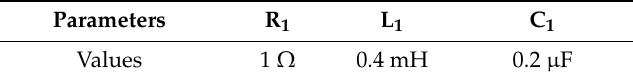
Table 1. The parameters of 1 km typical submarine cable.